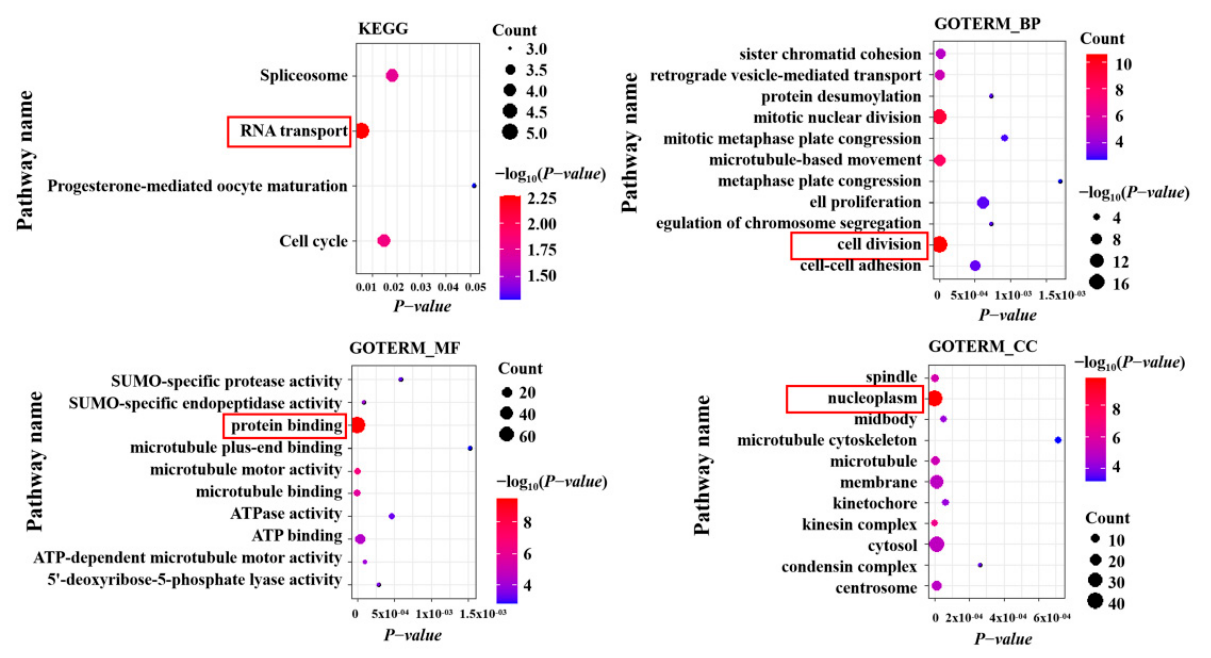
Figure 5. Functional enrichment analysis (including KEGG and GO) of IGF2BP2-associated genes in LUAD.